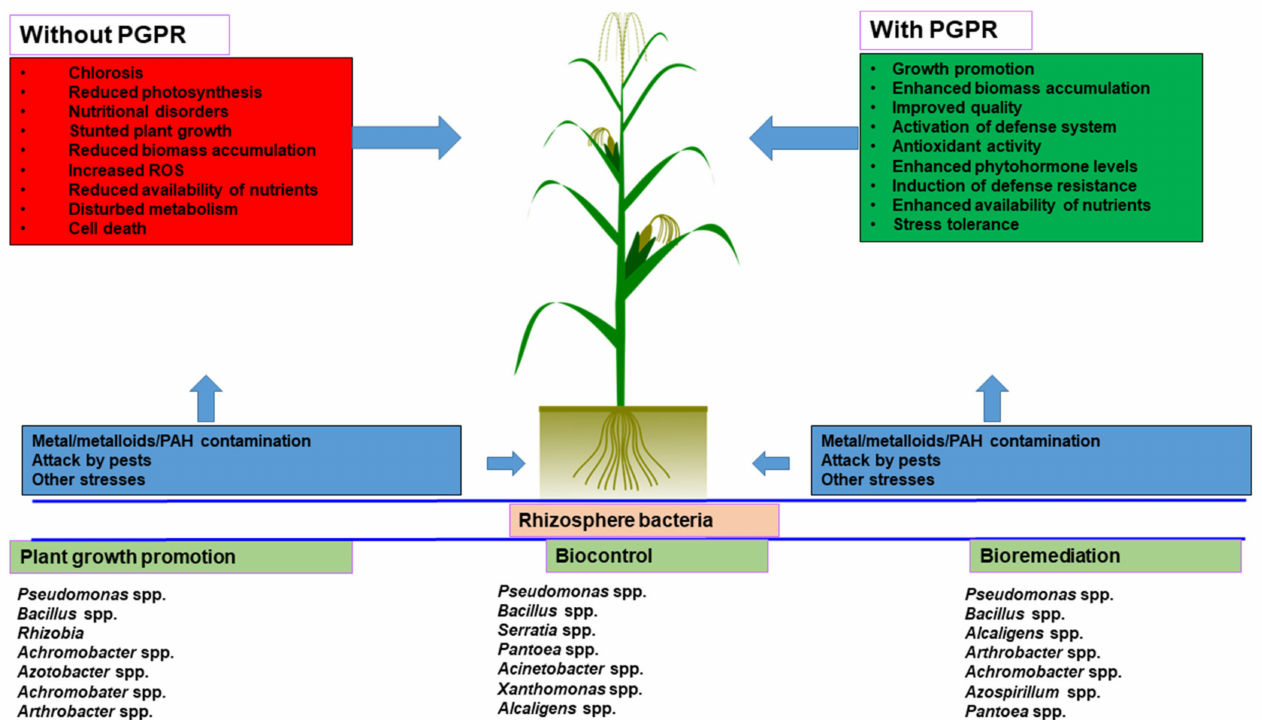
Figure 2. Consequences of stresses on plants without PGPR (left side) and with PGPR (right side). The bottom part shows the most studied microbial candidates involved in plant growth promotion, biocontrol, and bioremediation